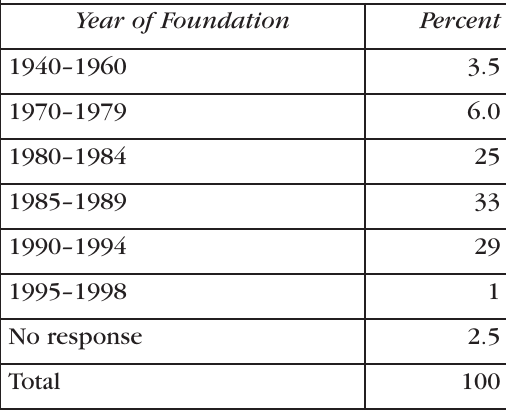
Table 3. Year Firms Were Founded Year of